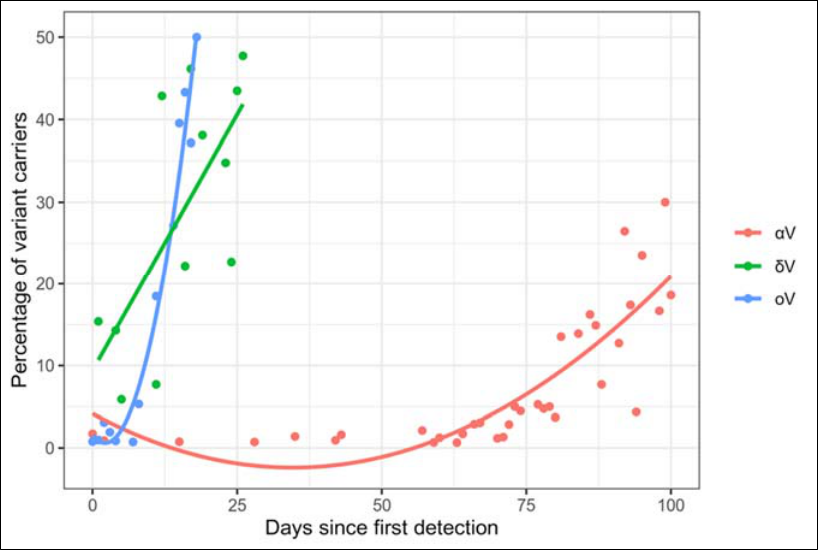
Figure 3. Comparison between the diffusion of oV versus α V and δ V in our cohort’s patients. The diffusion of α V and oV in our cohorts is described by different functions ( α V: y = 0.00005355 x 2 − 0.0085694 x + 0.0153644, oV: y = 0.0019871 x 2 − 0.003777 x + 0.04147; δ V: y = 0.01248 x + 0.09412). The solid lines represent the 2nd degree polynomial regressions for α V and oV and the linear regression for δ V.